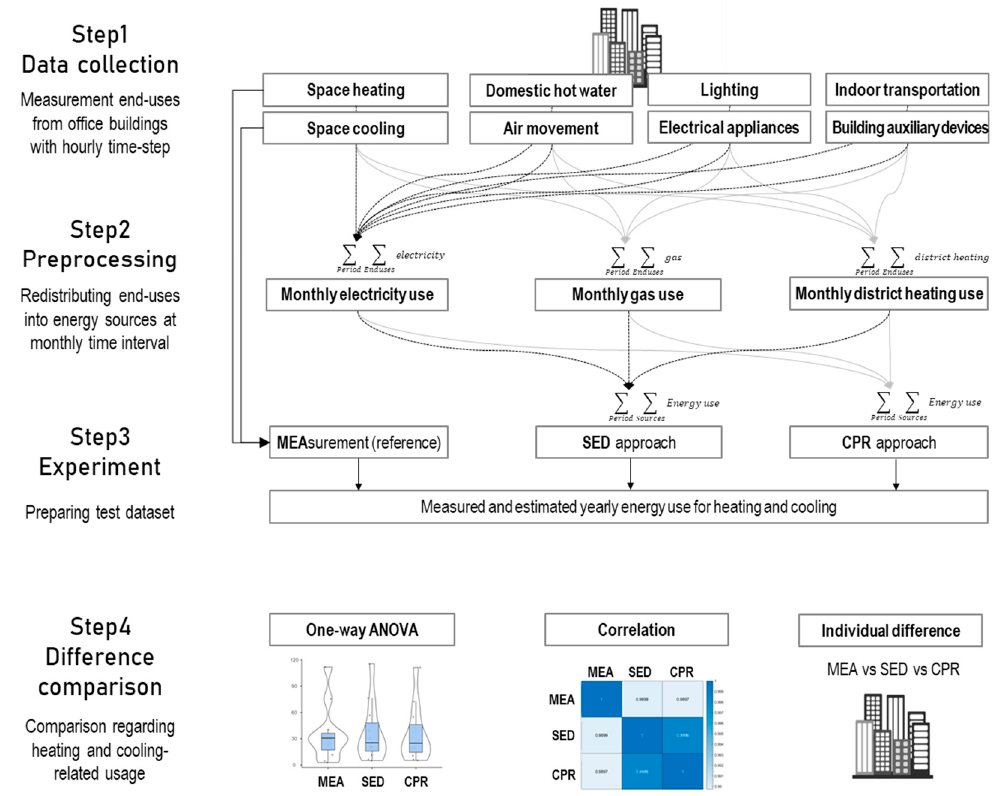
Figure 1. Research flowchart.